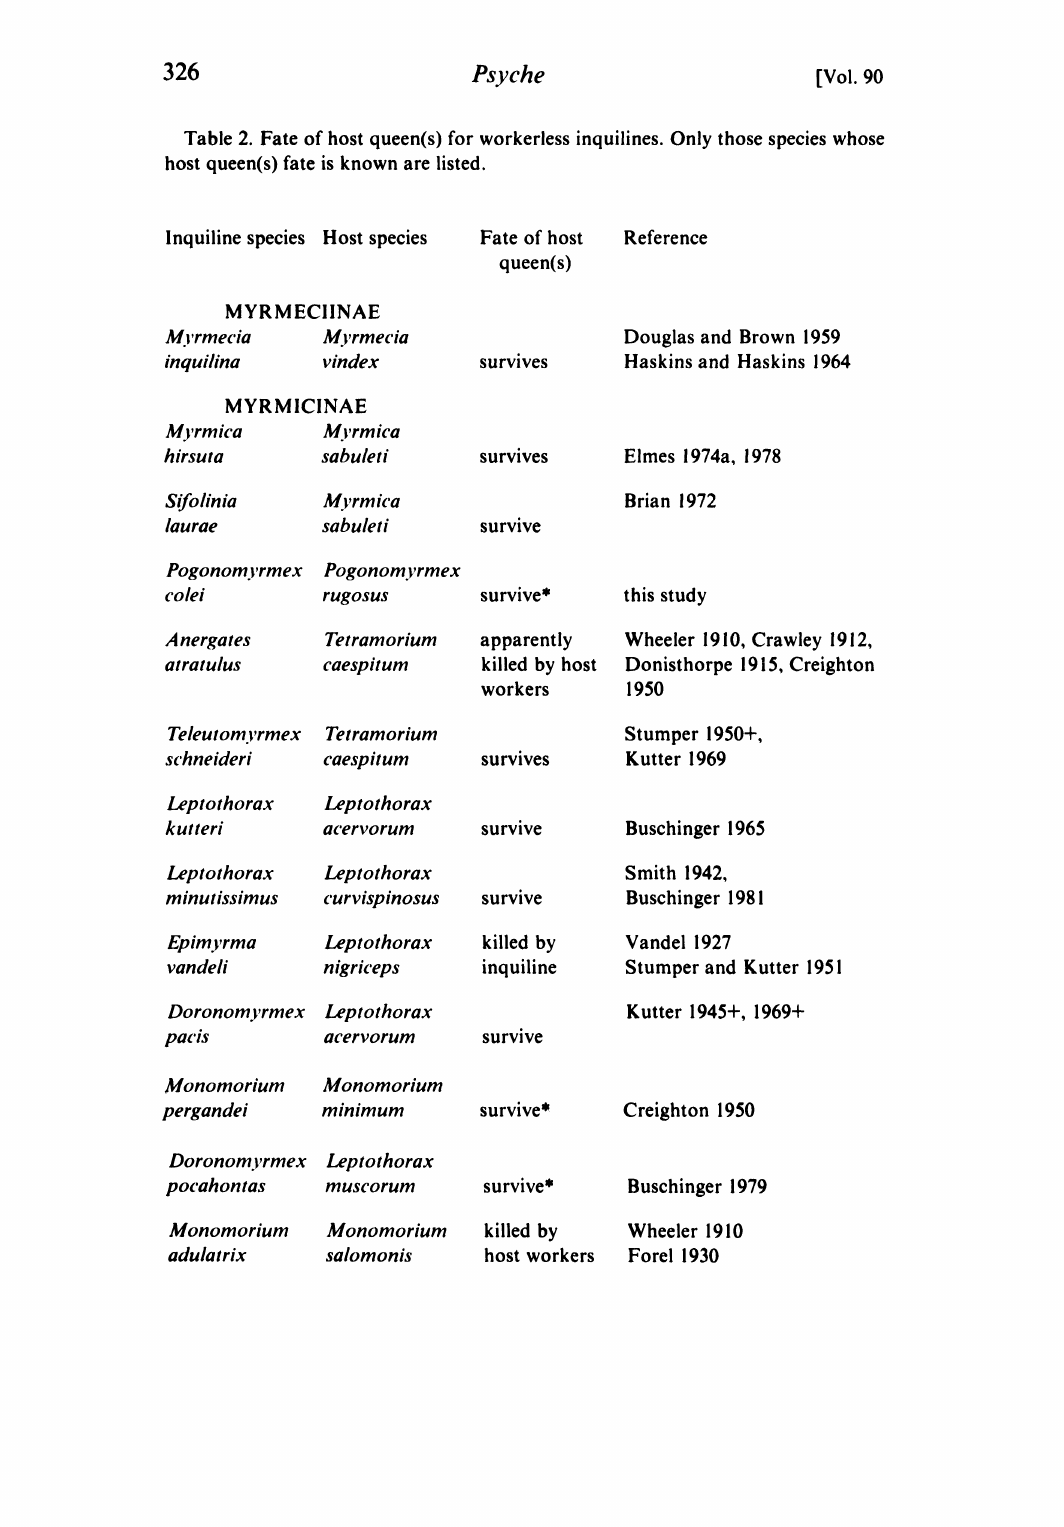
Table 2. Fate of host queen(s) for workerless inquilines. Only those species whose host queen(s) fate is known are